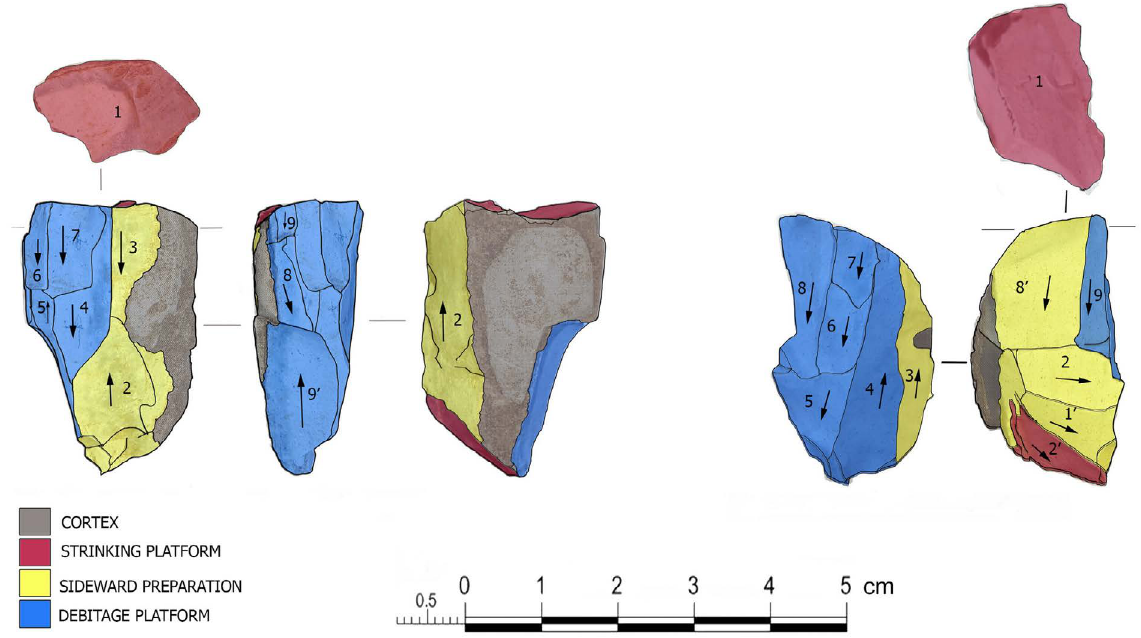
Figure 18. Assemblage of bipolar cores from Tajo de